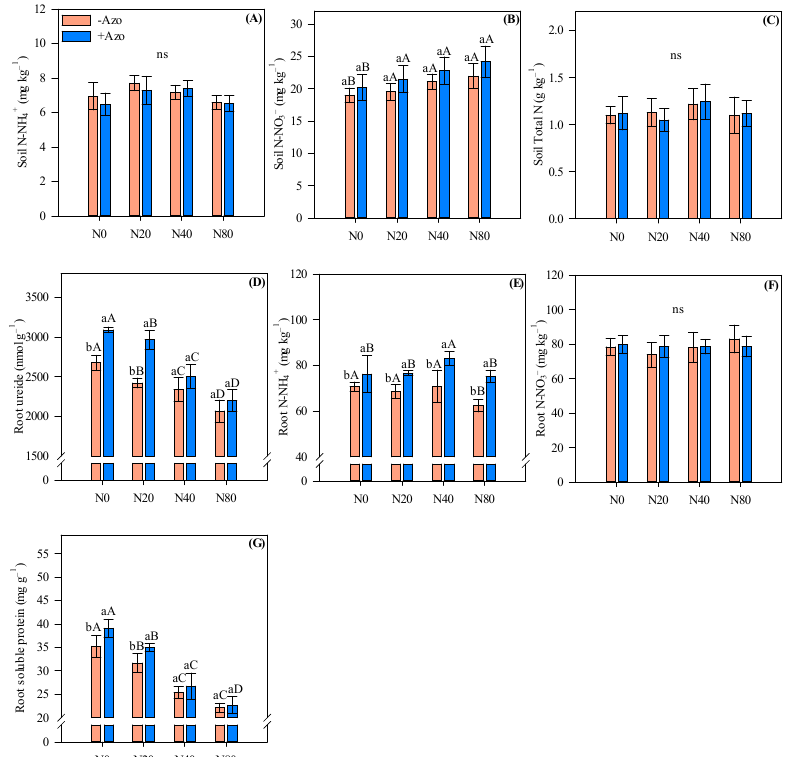
Figure 1. Soil ammonium (N-NH 4+ ) ( A ), nitrate (N-NO 3 − ) ( B ) and total N content ( C ), root ureides ( D ), root N-NH 4+ ( E ), root N-NO 3 − ( F ) and root soluble protein ( G ) concentrations in cowpea affected by inoculations and N fertilizer rates. Different letters indicate significant differences between treatments according to Tukey’s test ( p ≤ 0.05). Interaction between inoculations and N levels: Lowercase letters indicate significant differences between inoculations, and uppercase letters indicate significant differences between N levels according to Tukey’s test ( p ≤ 0.05). ns = non-significant. Error bars indicate standard deviations ( n = 4). −Azo and +Azo refer to the single inoculation with Bradyrhizobium sp. and co-inoculation with Bradyrhizobium sp. + A. brasilense, respectively; N0, N20, N40 and N80 refer to absence, 20, 40 and 80 kg N ha −1 applied.